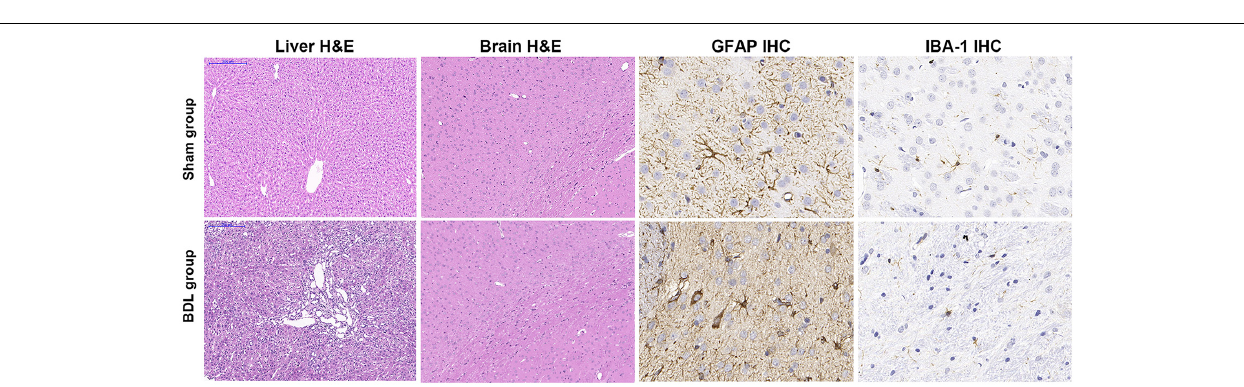
FIGURE 2 | Representative [ 18 F]DPA-714 and [ 18 F]PBR146 micro-PET/CT images of sham and BDL rats. Brain regions, including the basal ganglia, cingulate cortex, auditory cortex, motor cortex, somatosensory cortex, hippocampus, thalamus, midbrain, and medulla, showed significant differences in average%ID/g values between the sham and BDL groups. The [ 18 F]DPA-714 and [ 18 F]PBR146 micro-PET/CT showed consistent results in these regions. BDL = bile duct ligation; L = left; R = right.